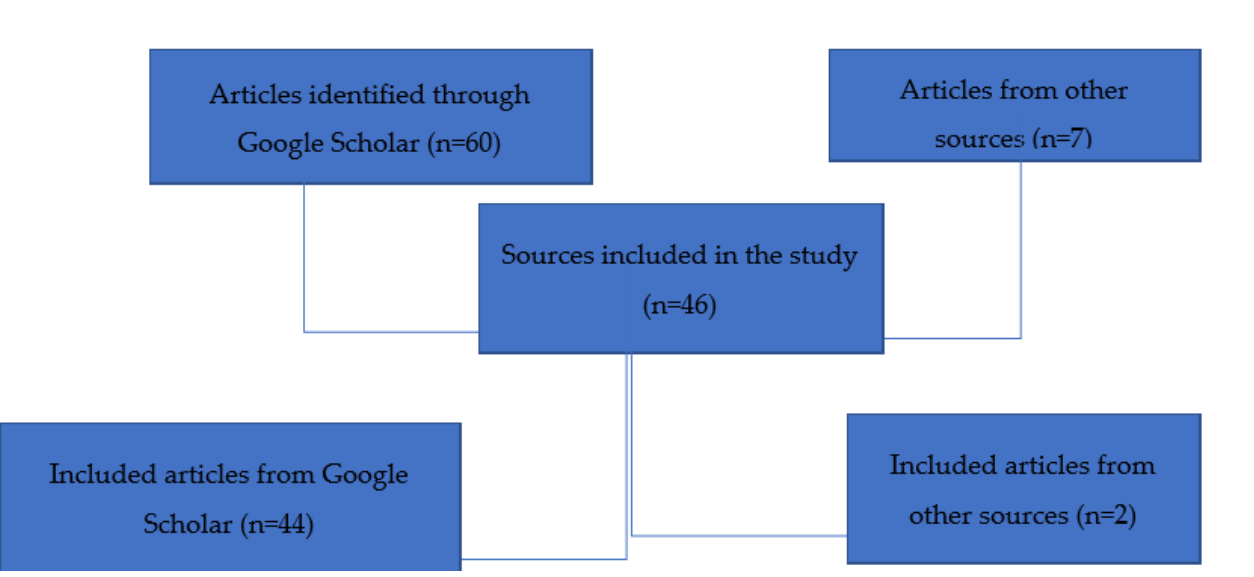
Figure 1. Selection of sources for the study.